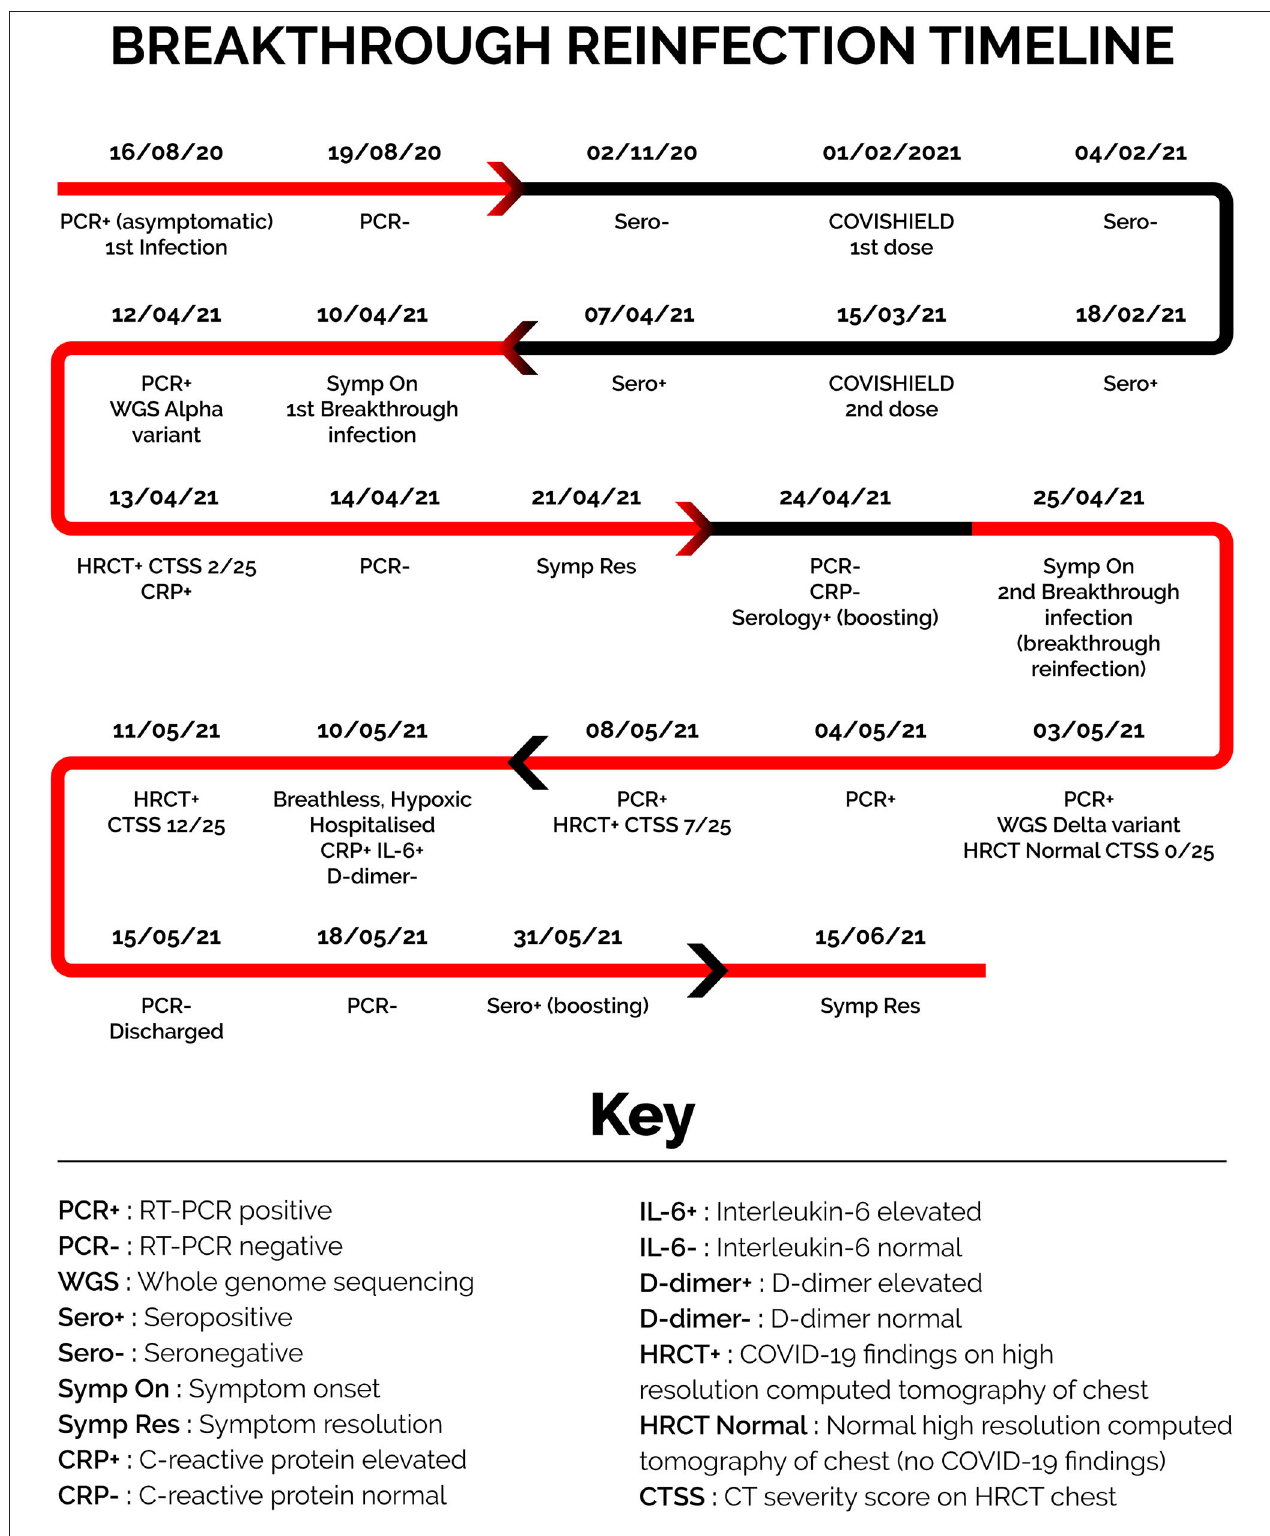
FIGURE 1 | Breakthrough reinfection